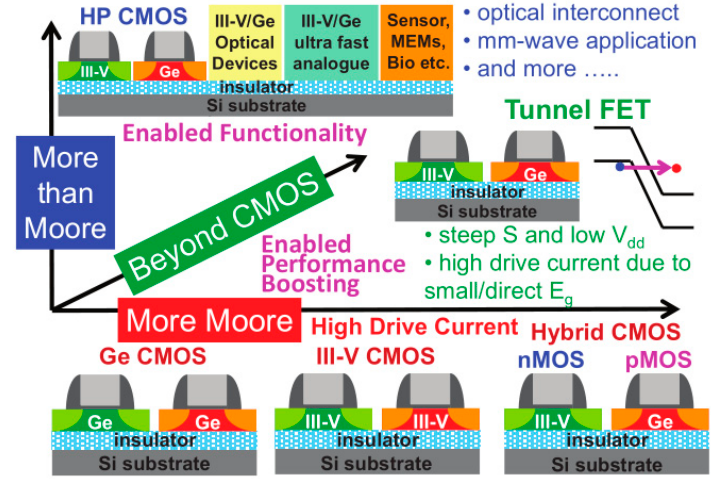
Figure 49. Possible evolution scenario for III–V/Ge devices on Si platform through heterogeneous integration [343].